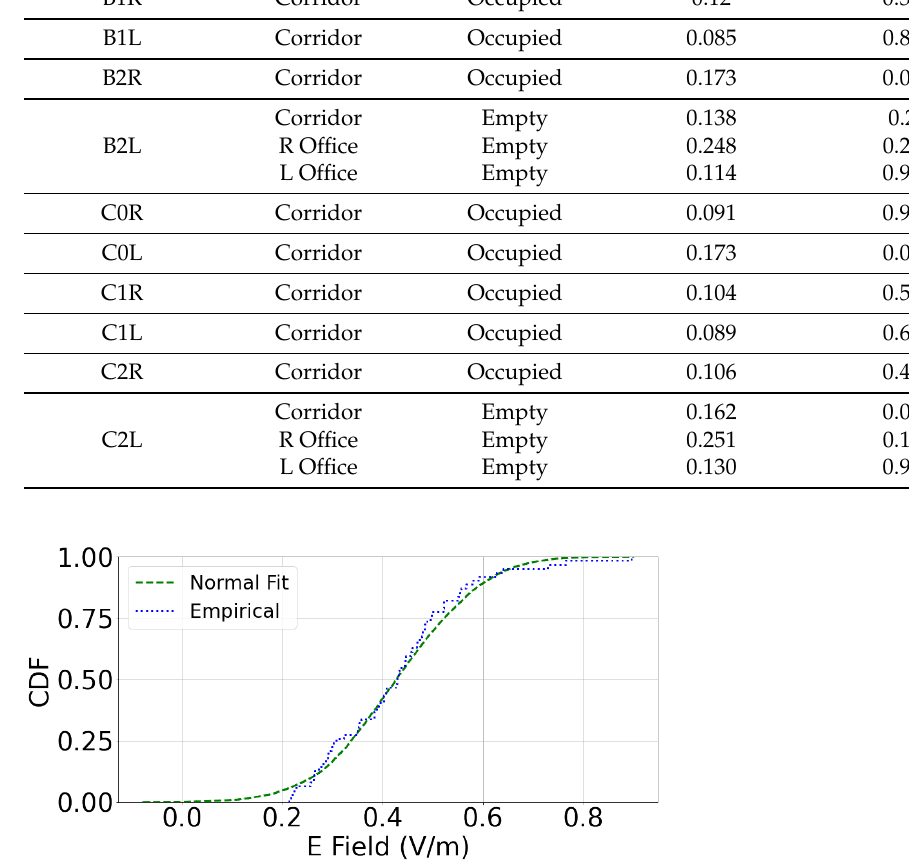
Figure 7. The CDFs of normal distribution and the empirically observed distribution of